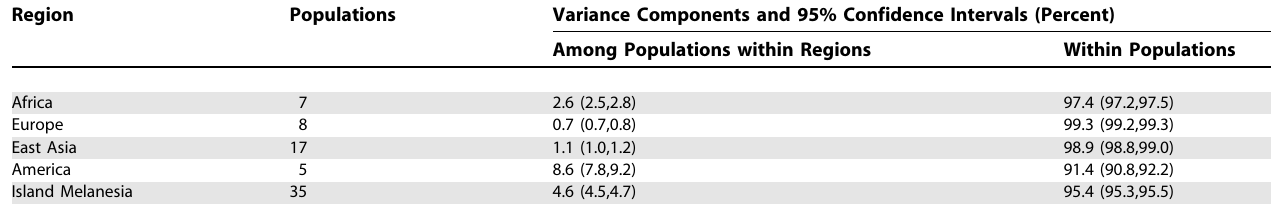
Table 1. Analysis of Molecular Variance (AMOVA) for 687 Microsatellites for Major Regions (HGDP-CEPH plus Pacific) Region Populations Variance Components and 95% Confidence Intervals (Percent) Among Populations within